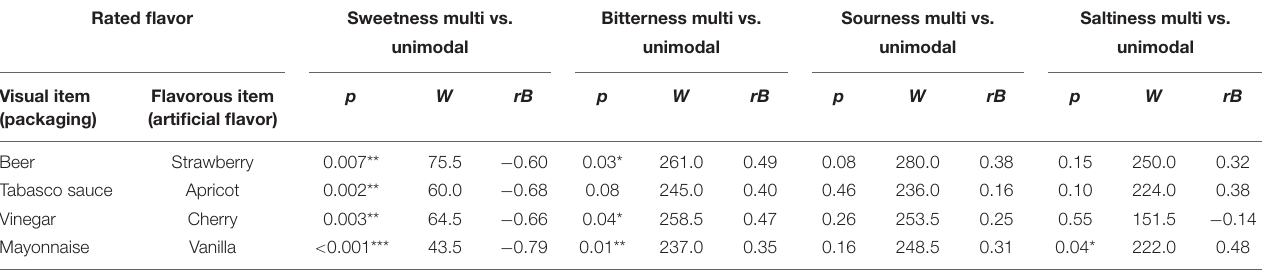
TABLE 1 | Wilcoxon signed-rank tests comparing the perceived flavor between the flavorous unimodal and the multimodal stimulation during the flavor modulation task ( N = 28; *** p < 0.001, ** p < 0.01, * p < 0.05). Rated flavor Sweetness multi vs. Bitterness multi vs.